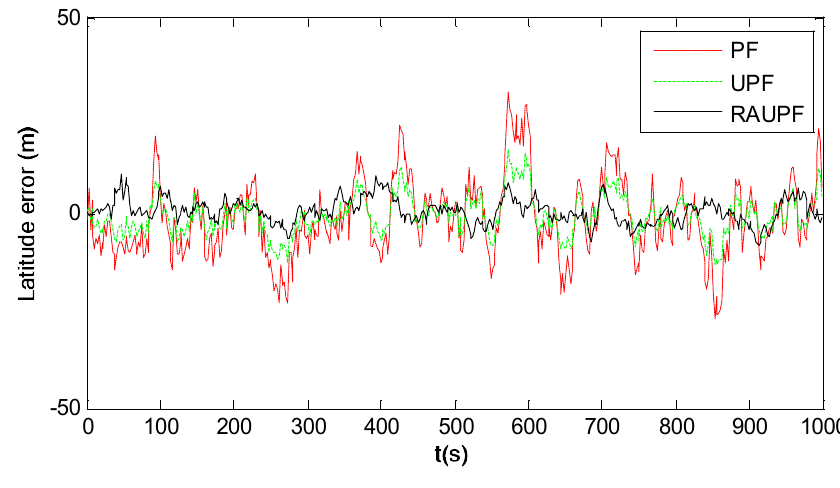
Figure 13. Latitude errors of PF, UPF and RAUPF ( M =